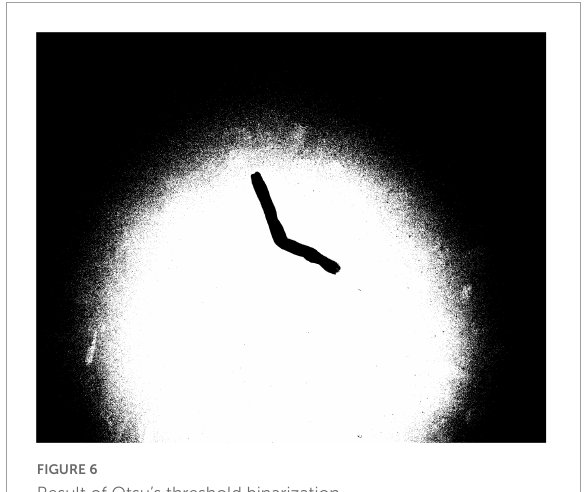
FIGURE6 Result of Otsu’s threshold